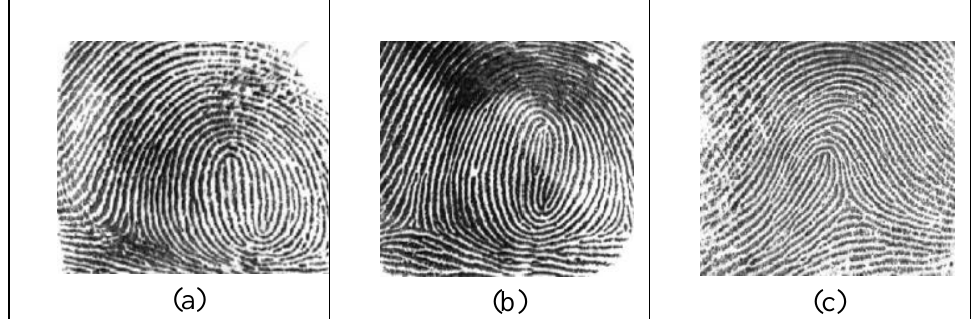
Figure 7. Fingerprints of identical twins (a, b), and fingerprint of another person (c)